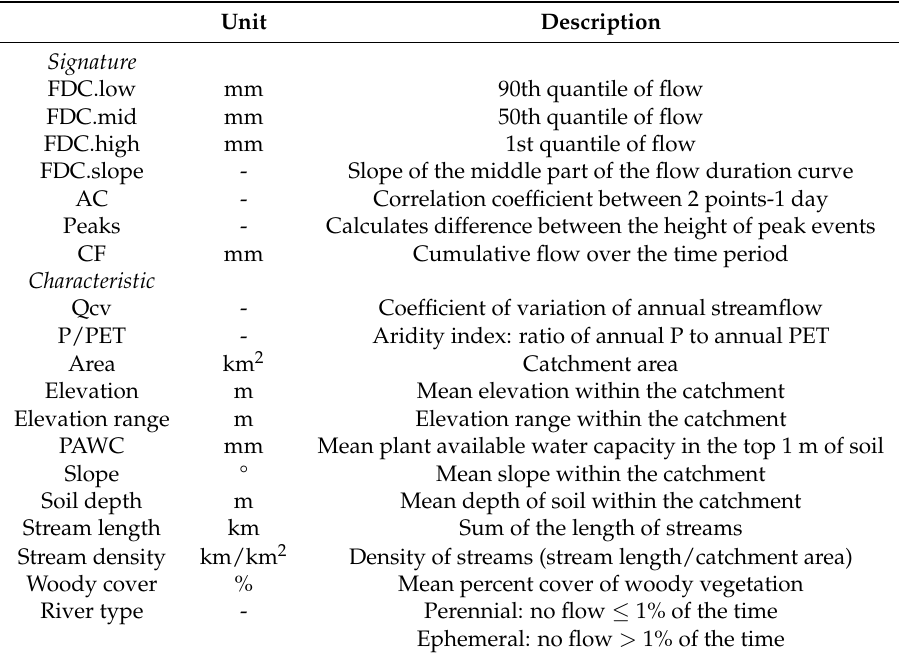
Table 1. Descriptions of the hydrological signatures and catchment characteristics used in this